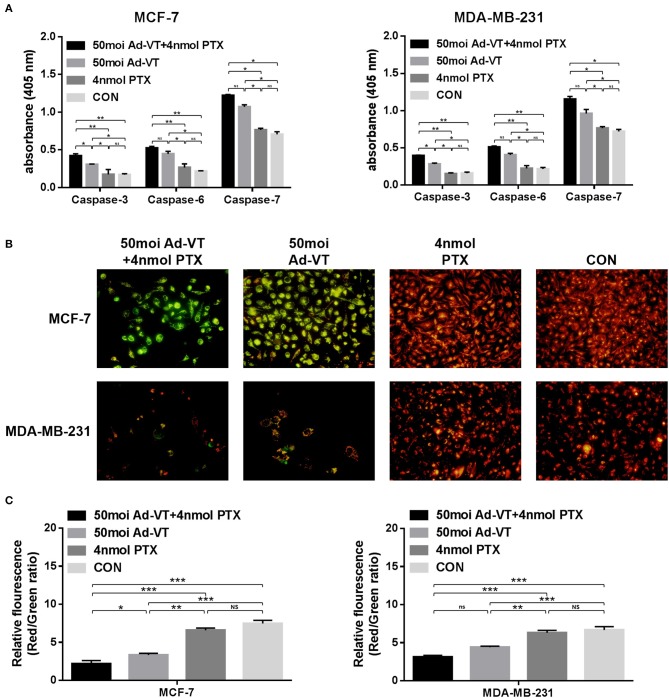
Analysis of mitochondrial membrane potential by JC-1 staining and analysis of caspase activation in MCF-7 and MDA-MB-231 cells infected with a combination Ad-VT and paclitaxel. (A) Cells were treated with the Ad-VT, paclitaxel and Ad-VT and paclitaxel mixture for 72 h. The vertical coordinate for the content of caspases was in units of μg/μl. The levels of caspases-3, 6, and 7 increased significantly in Ad-VT and in the combination Ad-VT and paclitaxel groups. (B) Changes in red and green fluorescence measured by fluorescence microscopy after JC-1 staining. Increased apoptosis results in a decrease in the ratio of red to green fluorescence. (C) Quantitative measurement of changes in the ratio of red to green fluorescence after JC-1 staining. Ad-VT and the combination Ad-VT and paclitaxel clearly altered the mitochondrial membrane potential, and combination of Ad-VT and paclitaxel had the strongest ability to induce apoptosis by affecting the mitochondrial membrane potential. All measurements were performed in triplicate. *p < 0.05, **p < 0.01, ***p < 0.001.